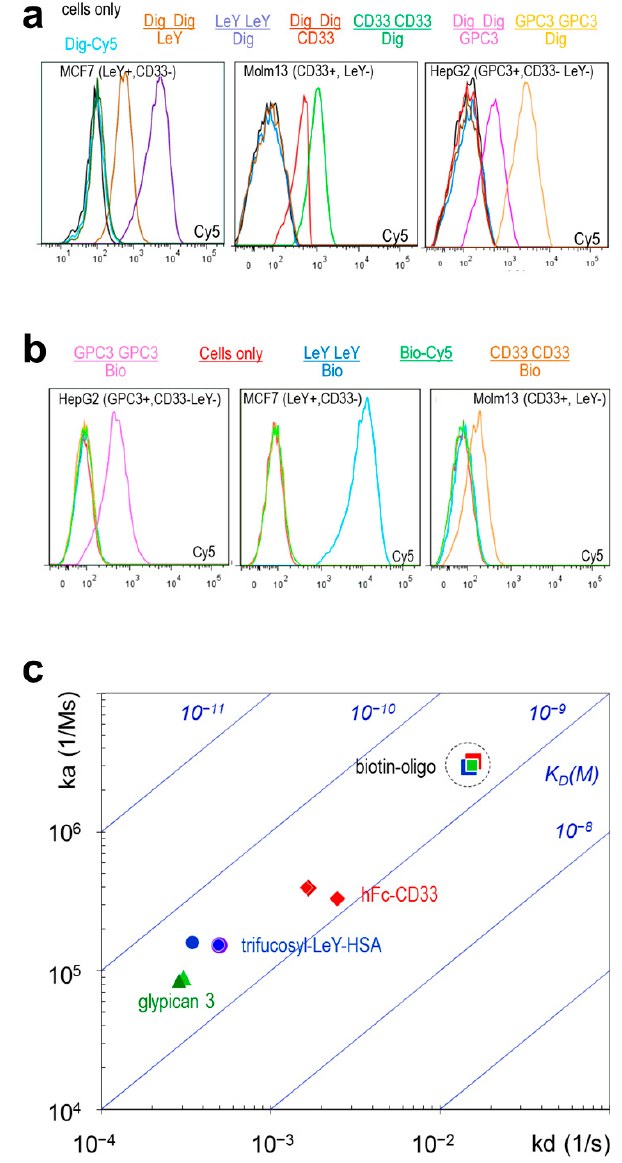
Figure 2. TriFab mediated targeted delivery of a small molecule. ( a ) TriFabs specific for glypican3 (GPC3, [12]), CD33 or LeY [11] combined with Dig-specificity were tested by FACS on LeY+,CD33 − MCF7, CD33+,LeY − MOLM13 and GPC3+,Ley − ,CD33 − HepG2 cells with Dig-Cy5 payload [11]. “+” indicates expression of the listed antigen “ − “indicates lack of expression. The binding specificities of the Fab arms are represented for each analysed molecule as “numerator” and the specificity of the Fv in the stem region as “denominator” with matched colour (except for Dig-Cy5 only or cells only which are light blue or black, respectively). Specific cell surface and hapten-binding is observed for TriFabs that bind cells with Fab arms and hapten in the stem region. Specific cell surface and hapten-binding is also observed for TriFabs that bind hapten bivalent with Fab arms and CD33 or GPC3 or LeY monovalent in the stem region; ( b ) TriFabs that have the Dig-binding moiety replaced by Biotin-binding moieties show same functionality when coupled to the payload Bio-Cy5 [13,14]; ( c ) Comparison of the SPR-determined affinities of Biotin-binding TriFabs which bind cell surface antigens with their Fab arms (bivalent) and Biotin (monovalent) with their stem-Fv. Listed are the on (ka) and off rates (kd) on y - and x -axes, respectively, as well as the resulting KD values (diagonal panels). Dashed circle: the Bio-binding of the stem region remains unaltered irrespective of which target antigen is addressed by the TriFab.